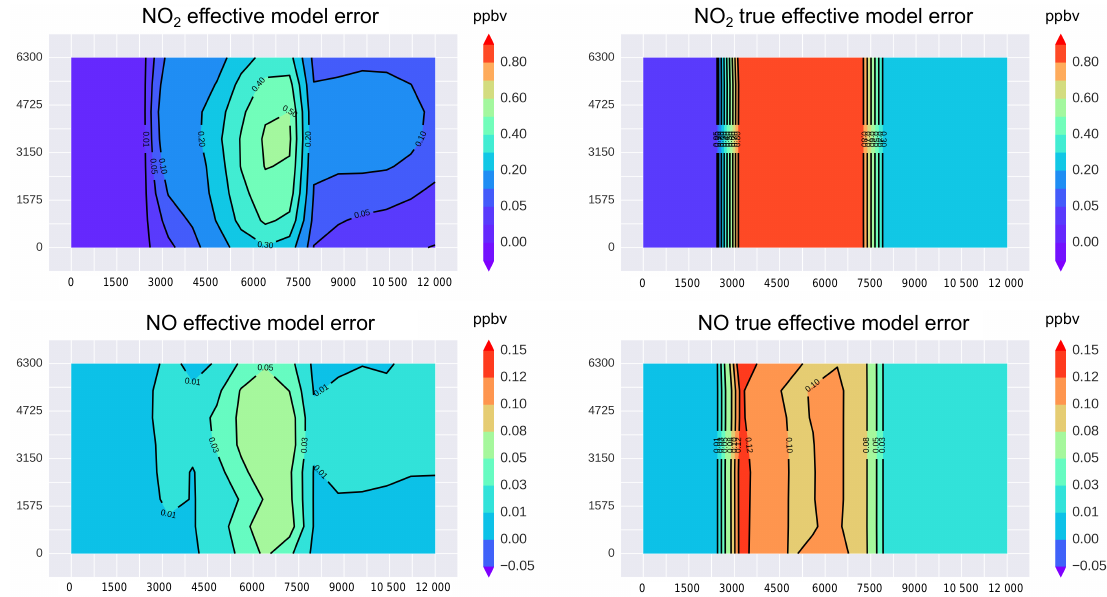
Figure 11. Temporal averages (24h) of the estimated effective model error (in ppbv) for the multivariate DA experiment in Fig. 10. Estimated effective model error for NO 2 on top and NO on bottom. On the right, the true effective model error is displayed for both species. Table 7. DA RMSEs for seven cycles of analyses/next-day forecasts where all considered species are perturbed and assimilated, and with model error enabled. (cid:15) min , (cid:15) max and (cid:15) avg (in %) are the minimum, maximum and average values of the relative RMSE (Eq. 19 divided by the truth average) on the QG-Chem